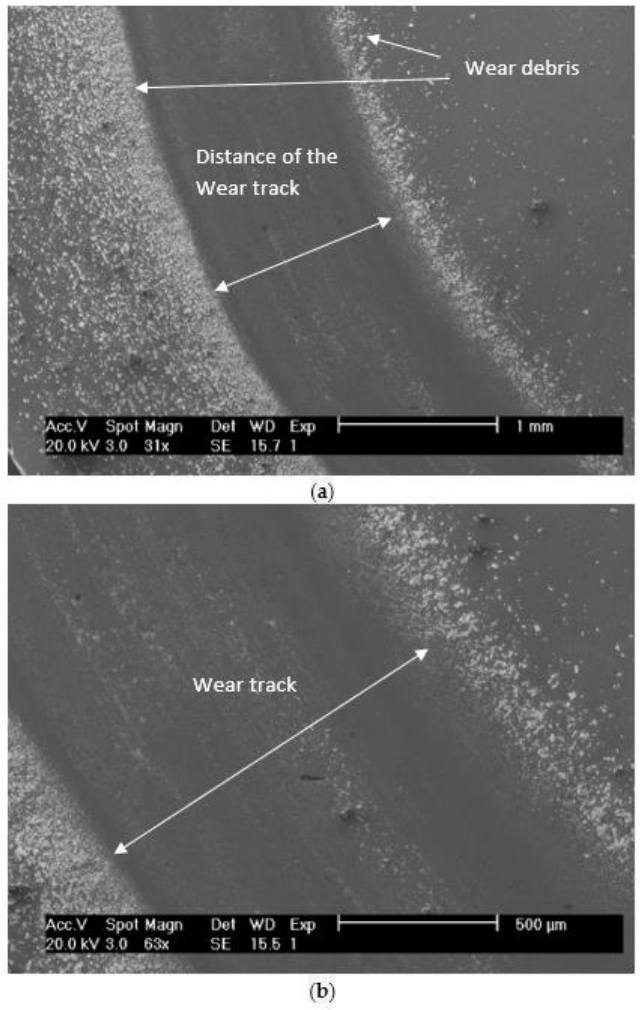
Figure 12. SEM micrographs of the wear track and debris resulting from the wear of system WC-AISI 304/Al 2 O 3 . According to a magnification of 31× ( a ), according to a magnification of 63× ( b ).